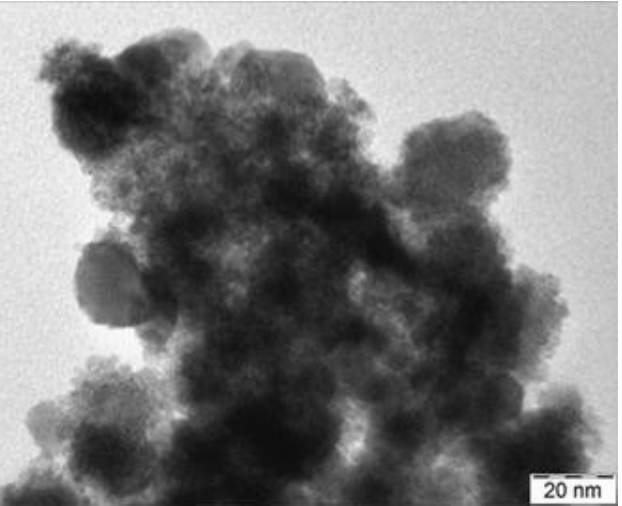
Figure 2. TEM micrograph of colloidal IrO 2 obtained through the colloidal method (Reprinted/adapted with permission from Ref. [97]).